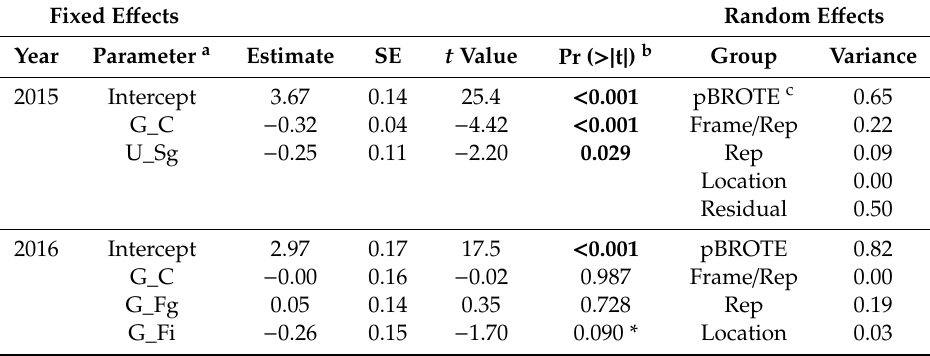
Table 3. The response of Bromus tectorum cover to grazing and / or herbicide treatments, analyzed using a linear mixed e ff ects model. All treatments (parameters) are with respect to the ungrazed control treatment (U_C), which is the intercept in the model. In 2015 only the grazed (G) and ungrazed control, and the spring applied herbicide treatment results are shown, because fall herbicide application had not yet occurred. Results are based on log transformed B. tectorum